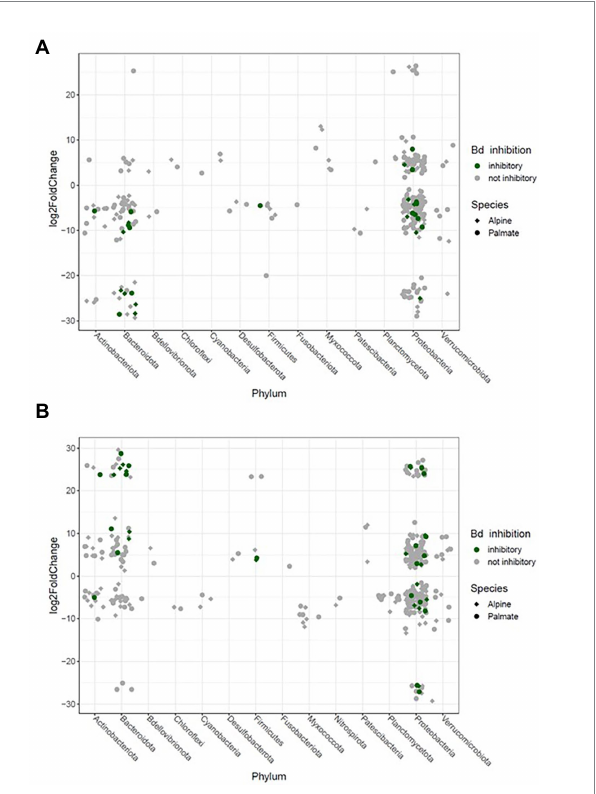
FIGURE 7 Significant log2 fold changes in abundance of bacterial phylotypes in the skin microbiota of captive newts over phase shifts from the first aquatic phase to the overwintering period (A) and from the overwintering period to the second aquatic phase (B) . Each phylotype is represented by a point whose position indicates the change in relative abundance throughout the transition, and whose shape characterizes the newt species in which it significantly varies in abundance. The color code indicates potential protective function of these phylotypes against Bd